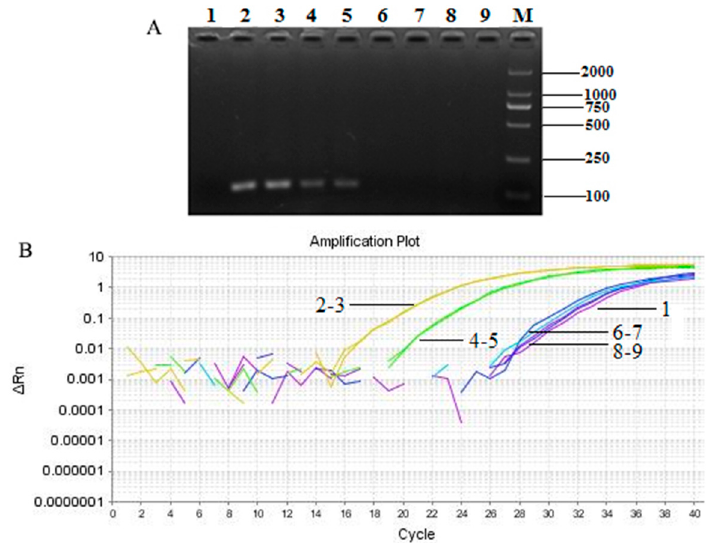
Figure 6. The detection of T. matsutake component in different kinds of food samples by qualitative ( A ) and real-time quantitative ( B ) PCR. 1: negative control; 2–3: positive control (Yunnan Shangri-La T. matsutake ); 4–5: T. matsutake biscuits; 6–7: T. matsutake sauce; 8–9: Oil field T. matsutake ; M: DNA marker DL 2000.